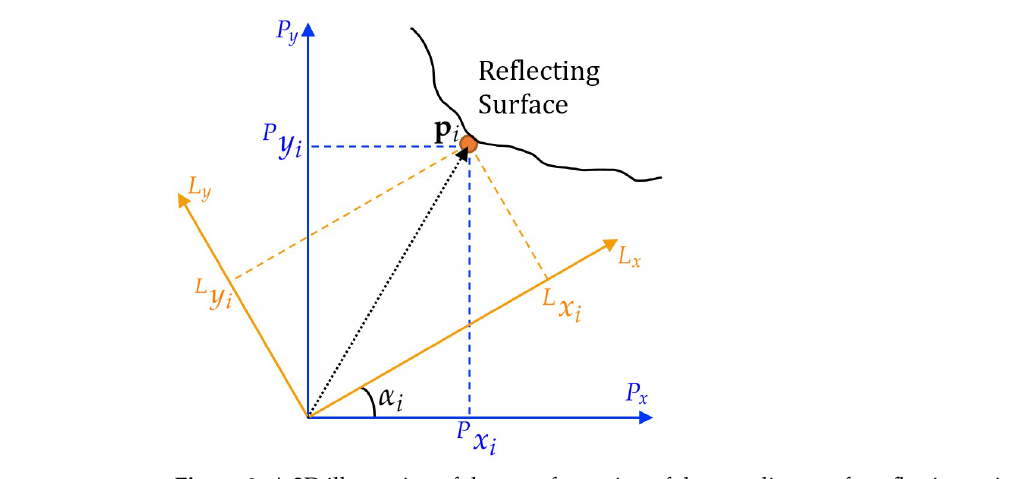
Figure 3. A 2D illustration of the transformation of the coordinates of a reflecting point from L -frame point to P -frame.